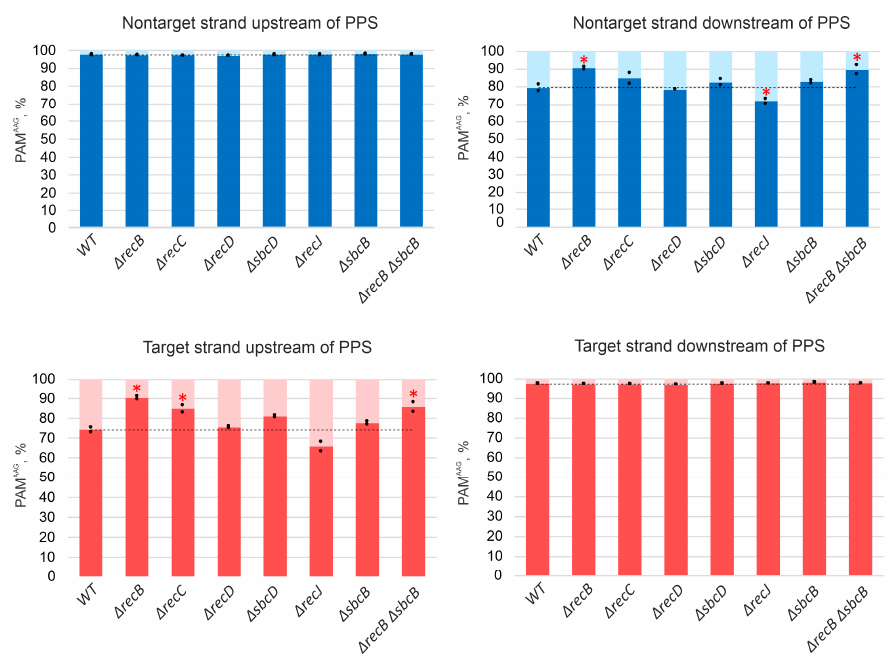
Figure 3. Association with the AAG PAM of spacers acquired by KD403 and its derivatives. Spacers acquired by indicated cells were mapped to an area within 200 kbp upstream and downstream of the PPS, and the percentage of mapping sites with an AAG PAM was determined separately for spacer mapping to upstream and downstream target and nontarget strands. The heights of bars show mean values obtained in two independent experiments (black dots show values obtained in each individual experiment). The dotted line shows the average level for the parental KD403 (“WT”) strain. Red asterisks mark values that significantly differ from the WT level according to pairwise proportional test with a p -value of 0.001.